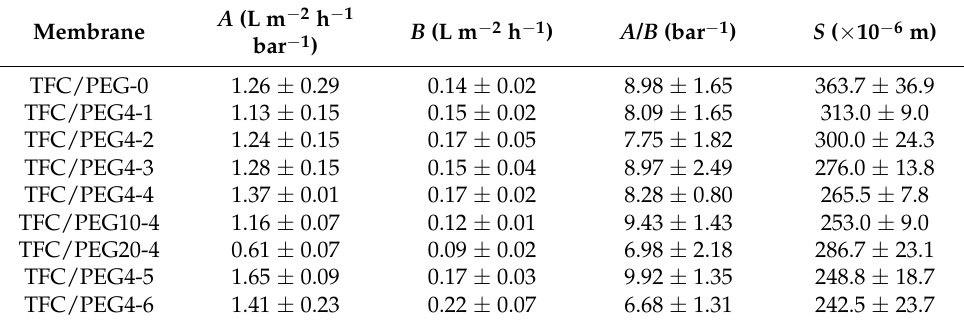
Table 5. Intrinsic properties of PSU/PEG supported TFC-FO membranes.